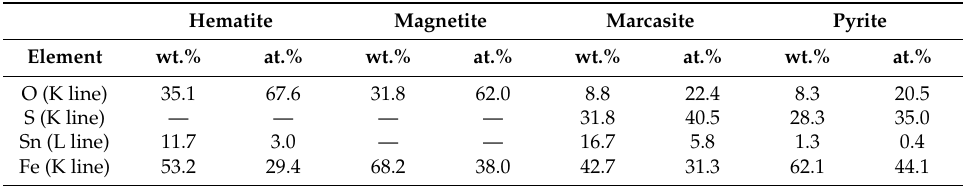
Table 3. EDX of samples with dominating phases. Line intensities were recalculated to weight and atomic percentages.